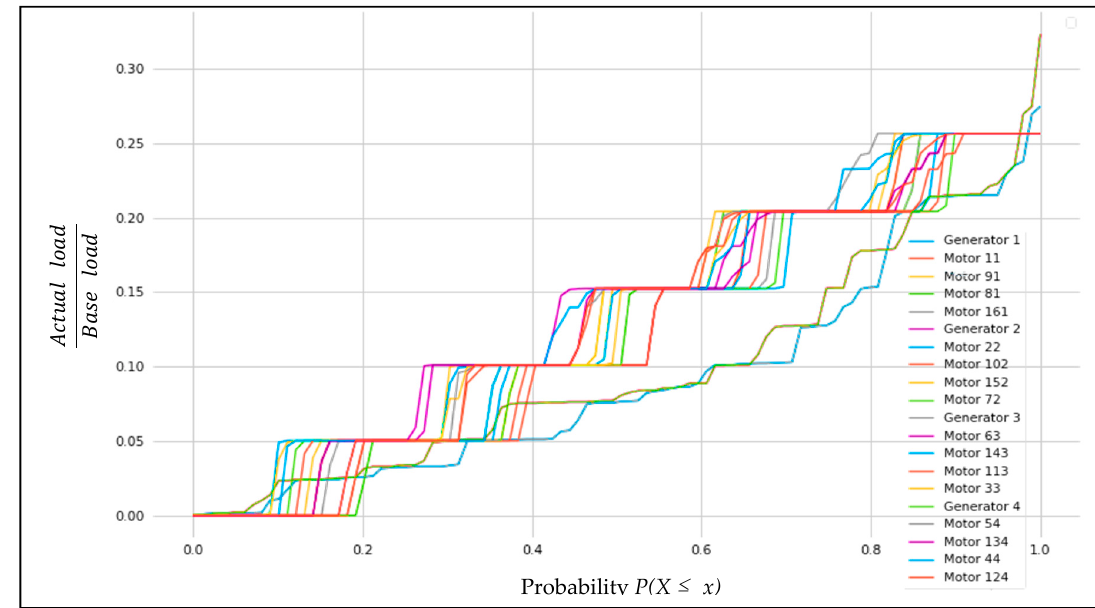
Figure 27. LH RTO branch load probability.